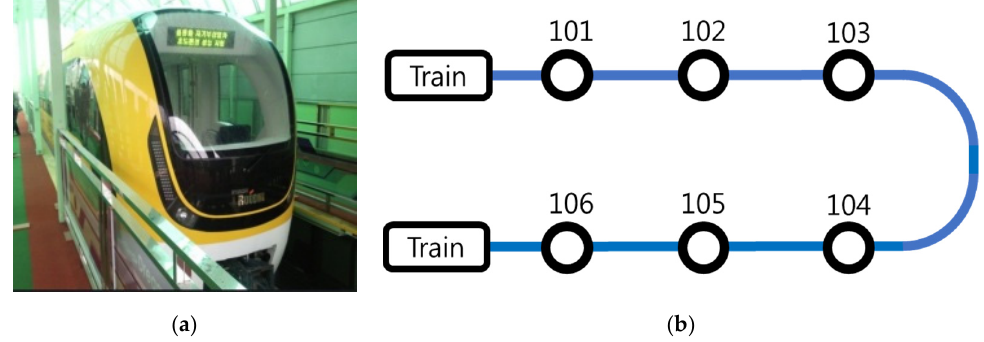
Figure 8. Actual vehicle test conditions and used vehicle: ( a ) Experimental linear induction motor (LIM) and ( b ) Train test-run section